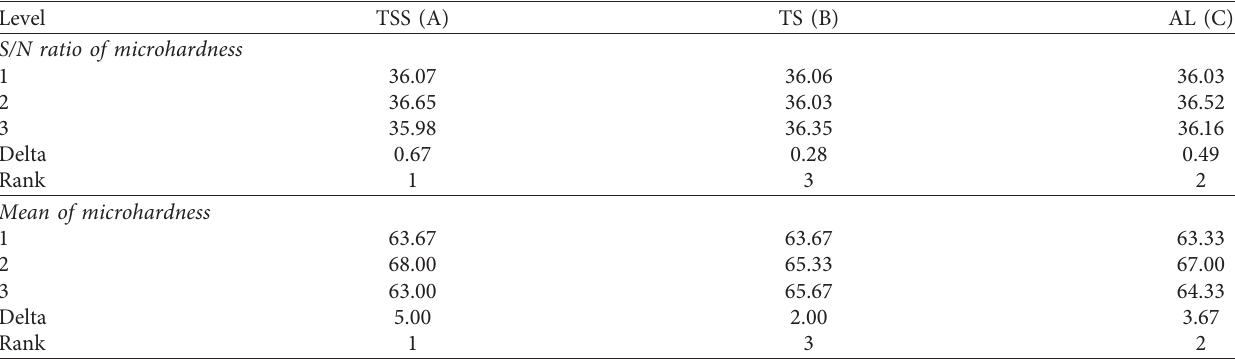
Table 7: Response table for